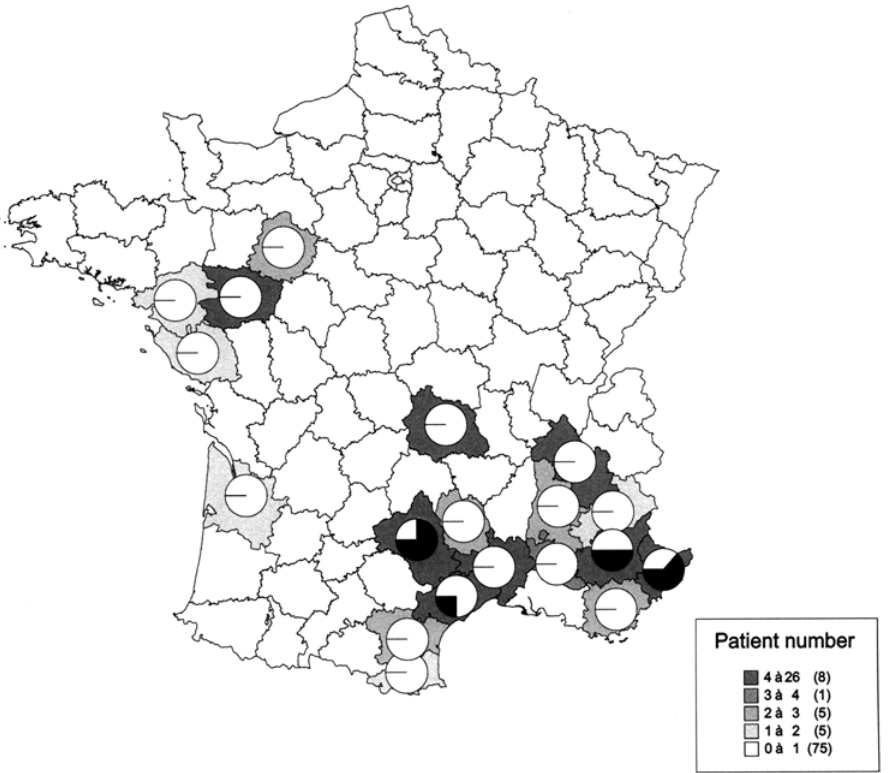
Figure 3. Distribution of classical and neurotoxic cases of envenomation in various regions of France. Pie charts show the relative numbers of classical (white) and neurotoxic (black) grade 2 and 3 envenomations. The total number of cases reported in each department is presented as grey levels, as indicated in the right bottom end corner of the figure.